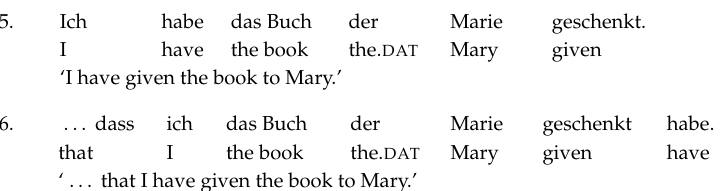
Figure 4. Structure of the German subordinate clause. The French and English main and embedded clauses do not differ from each other apart from the complementizer that usually introduces the embedded clause: Both are head ‐ initial with the inflected verb staying in T°. The participle moves to v°, hence entering the functional domain of the verb [1] (p. 95) (see also [20]). Again, examples (7) and (8) are represented by the tree ‐ structures in Figures 5 and 6 below. 7. J’